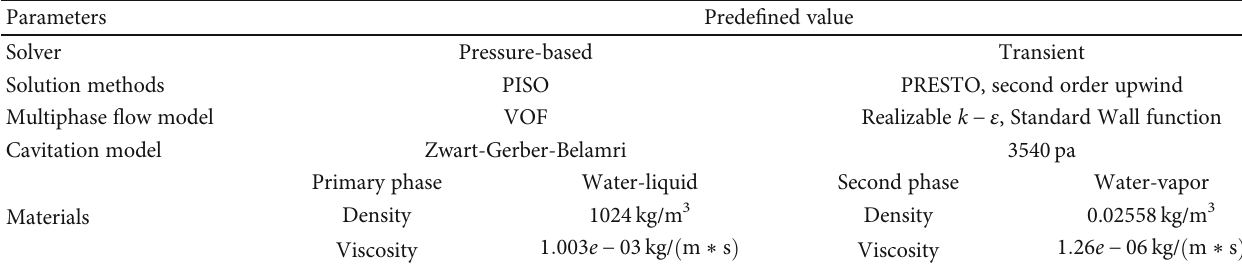
Table 1: Parameters of fl uent simulation.